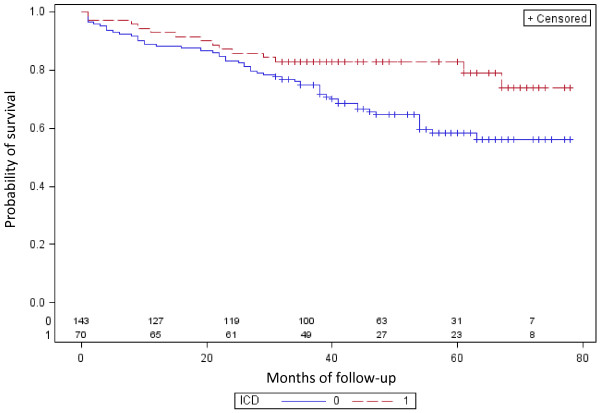
- Kaplan-Mayer overall survival in patients receiving ICD vs. conventional therapy. Legend: ICD, implantable cardioverter defirbillator